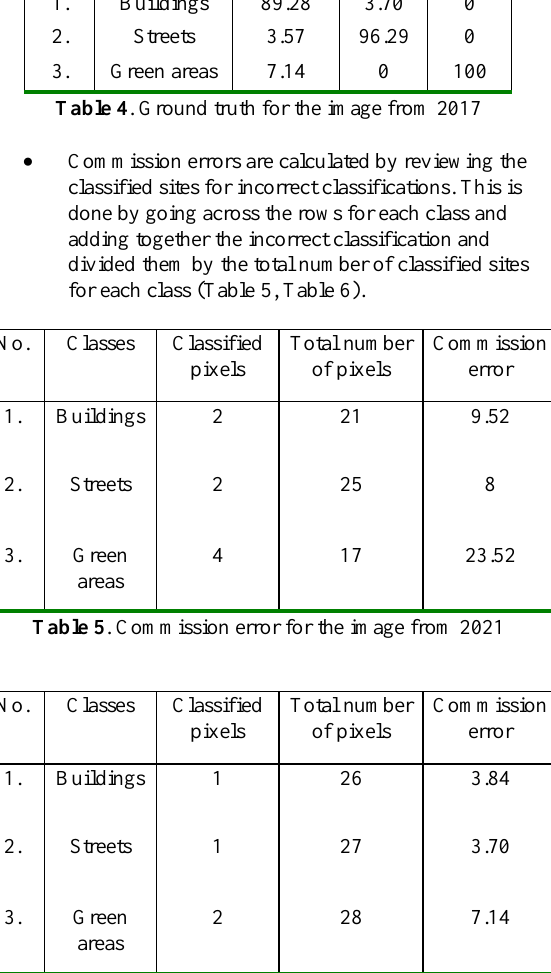
Table 6 . Commission error for the image from 2017 • Omission errors are calculated by reviewing the reference sites for incorrect classifications. This is done by going down the columns for each class and adding together the incorrect classifications and dividing them by the total number of reference sites for each class (Table 7, Table